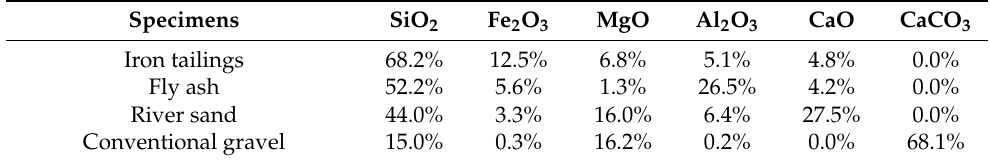
Table 1. Main chemical composition of concrete raw